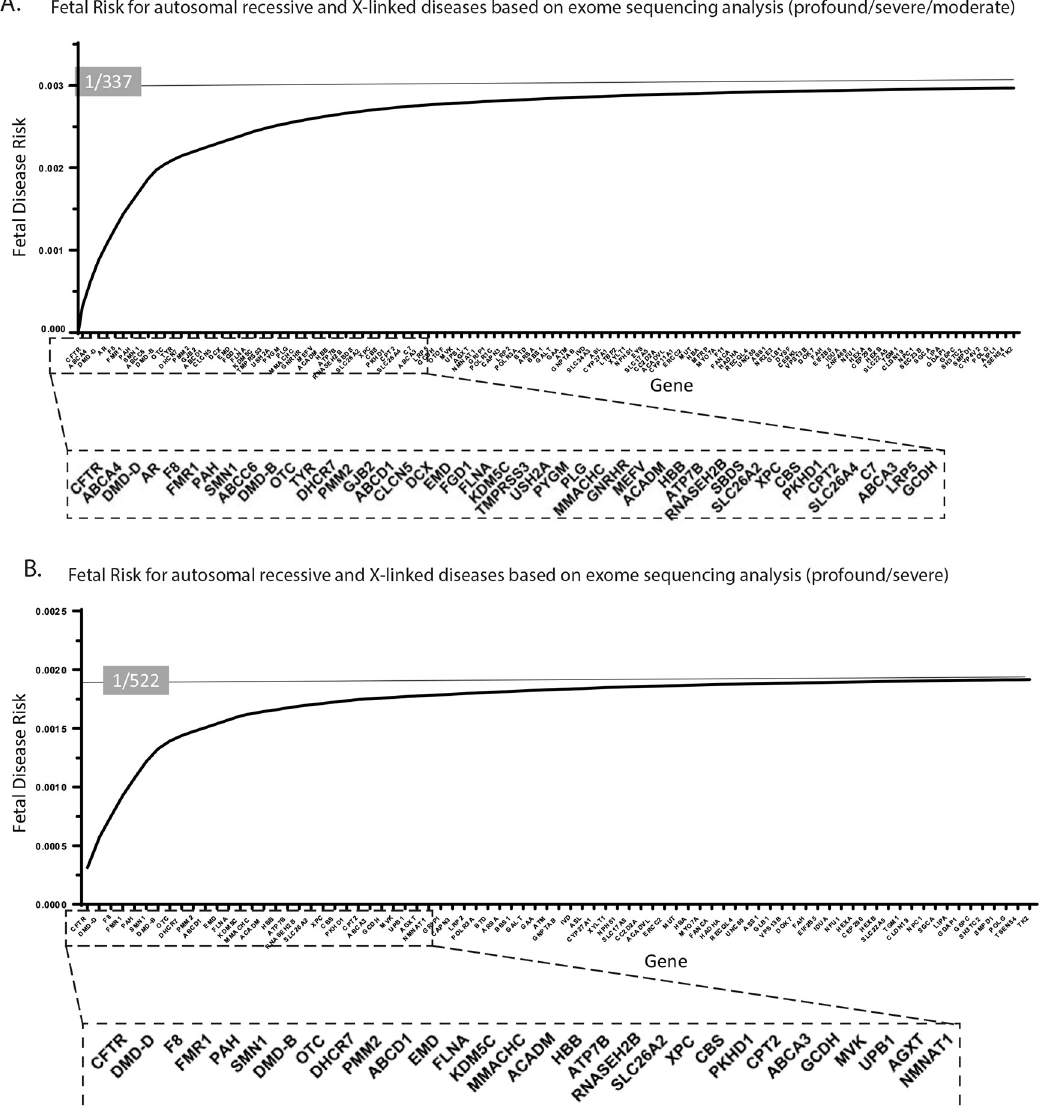
Fig 2. Aggregate fetal disease risk and utility score for 114 conditions from exome sequencing and tests. The full list of genes and the related carrier rate and characteristics are displayed in S2 Table. a) Aggregate fetal disease risk considering only severe and profound conditions. b) Aggregate fetal disease risk with moderate conditions